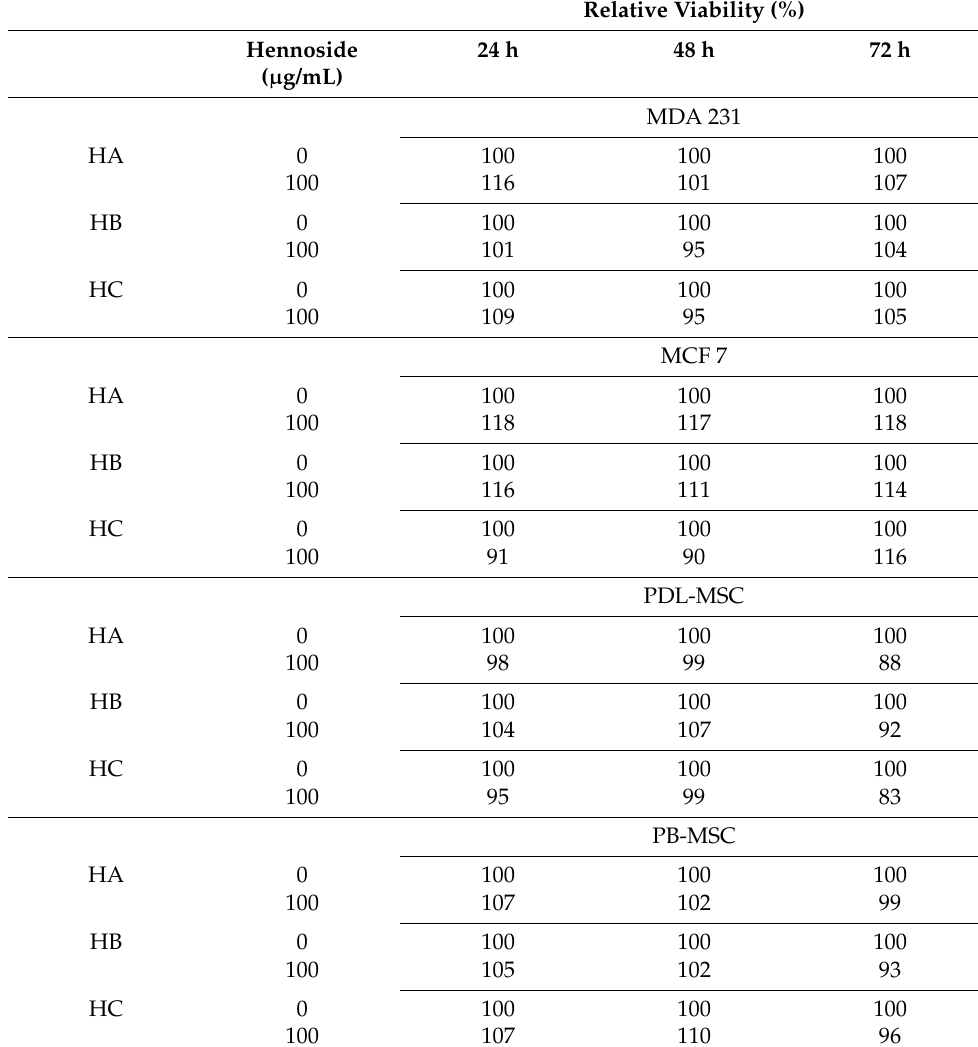
Table 2. Viability of hennoside-treated cells: MTT